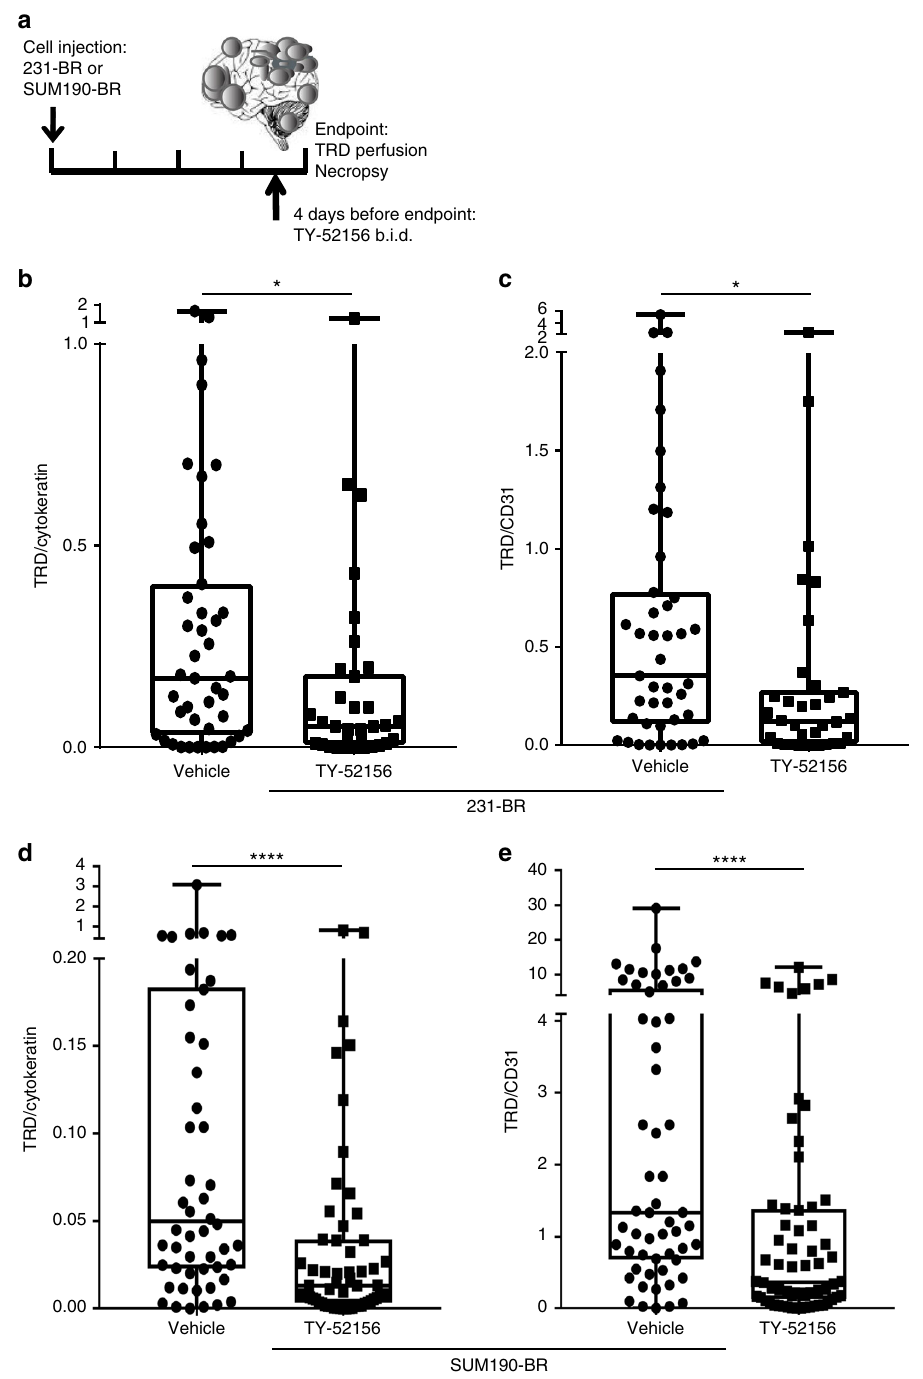
Fig. 7 TY-52156 strengthens the blood – tumor barrier in vivo. a Mice harboring experimental brain metastases from the 231-BR or the SUM190-BR received 10 mg kg − 1 TY-52156 or vehicle, b.i.d. by oral gavage, for 4 days. On the fourth day of treatment, mice were injected with TRD and perfused 10 min later. Brain and blood were taken at necropsy. b – e TRD pictures were taken, subsequently the same tissue slides were stained for human cytokeratin or CD31 to normalize TRD diffusion to either metastasis cellularity or blood vessel density, respectively. b , c Graphs represent metastatic clusters from 11 and eight mice for vehicle and 10 mg kg − 1 TY-52156, respectively. b TRD/cytokeratin intensity in 231-BR brain metastatic clusters. c TRD/CD31 intensity in 231-BR brain metastatic clusters. d , e Graphs represent metastatic clusters from fi ve and eight mice for vehicle and 10 mg kg − 1 TY-52156, respectively. d TRD/ cytokeratin intensity in SUM190-BR brain metastatic lesions. e TRD/CD31 intensity in SUM190-BR brain metastatic lesions. b – e One dot represents one cluster of metastases in the 231-BR model and one lesion in the SUM190-BR model. Graphs represent the median, the interquartile range (box), and the min/max values (error bars). Two-tailed Mann – Whitney statistical analysis; * P < 0.05; **** P <